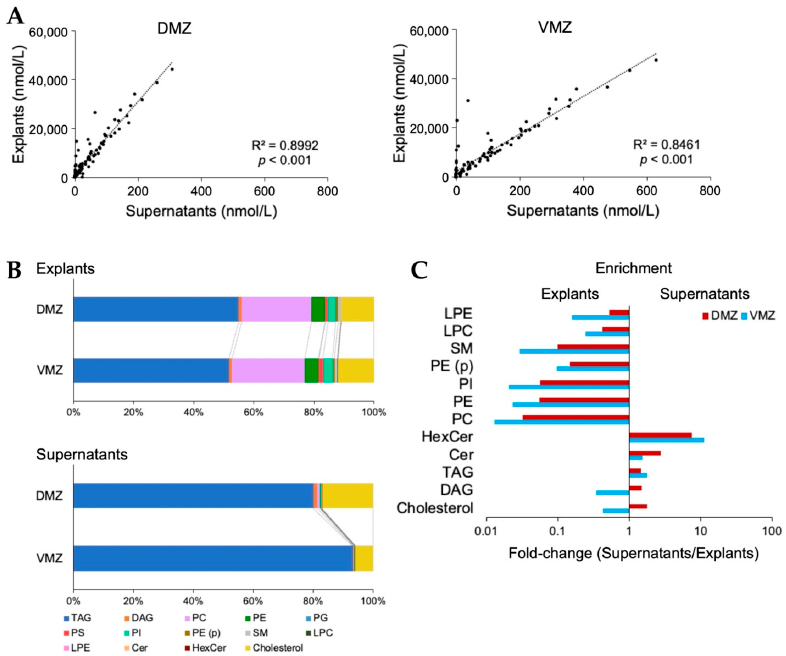
Figure 4. Lipid characteristics between the DMZ and VMZ in explants and supernatants. ( A ) Correlations of the lipids detected between explants and supernatants. ( B ) Bar graphs showing the proportion of each lipid class in the total lipid content. ( C ) Enrichment of lipid classes in explants and supernatants. The x -values are the ratios obtained by dividing the proportion in supernatants by that in explants. Any lipid class whose value was zero was excluded. TAG, triacylglycerol; DAG, diacylglycerol; PC, phosphatidylcholine; PE, phosphatidylethanolamine; PG, phosphatidylglycerol; PS, phosphatidylserine; PI, phosphatidylinositol; PE (p), alkenyl-acyl phosphatidylethanolamine; SM, sphingomyelin; LPC, lysophosphatidylcholine; LPE, lysophosphatidylethanolamine; Cer, ceramide; HexCer, hexosylceramides.